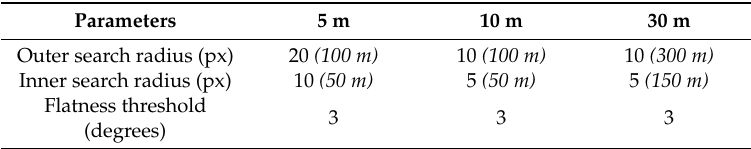
Table 4. Parameters of the moving window sizes in pixels (px) used in this approach for the three different pixel resolutions. Cell sizes in meters are shown in parentheses.